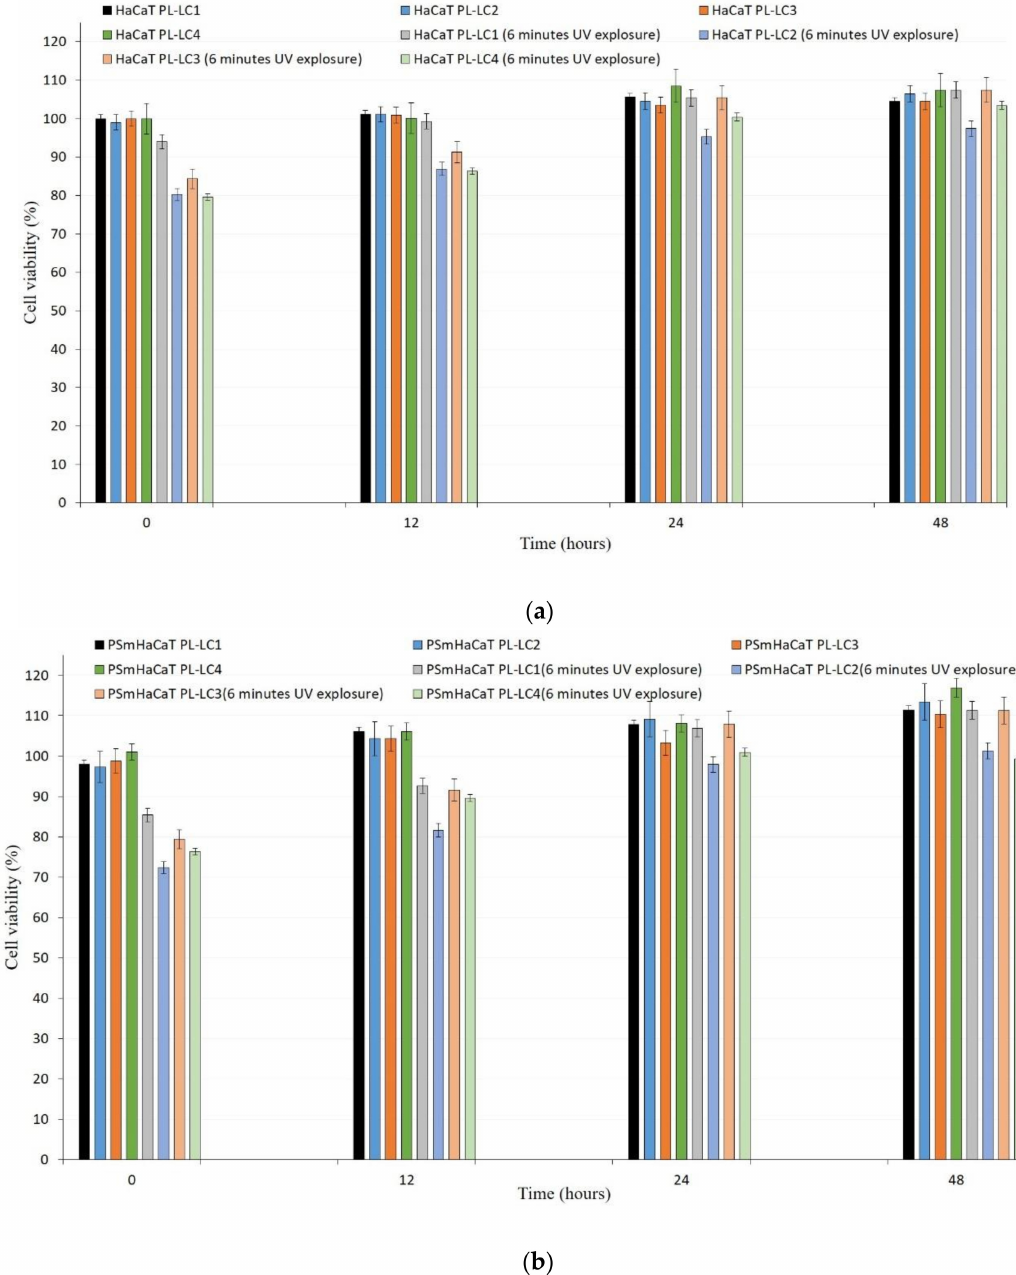
Figure 9. Cell viability evaluation with MTT assay on PL-LC 1–4) pretreated HaCaT ( a ) and PSmHaCaT ( b ) cells after 6 min of UV exposure and their recovery. Each data point represents the mean ± SD, n =